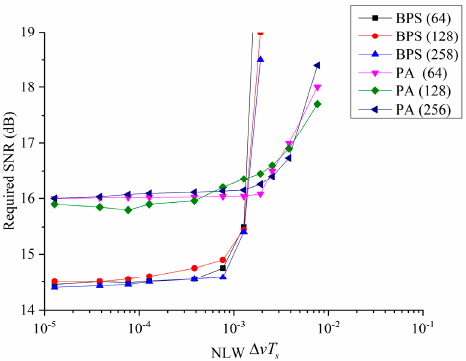
Figure 6. NLW tolerance for the PA and BPS algorithms under different subcarriers.